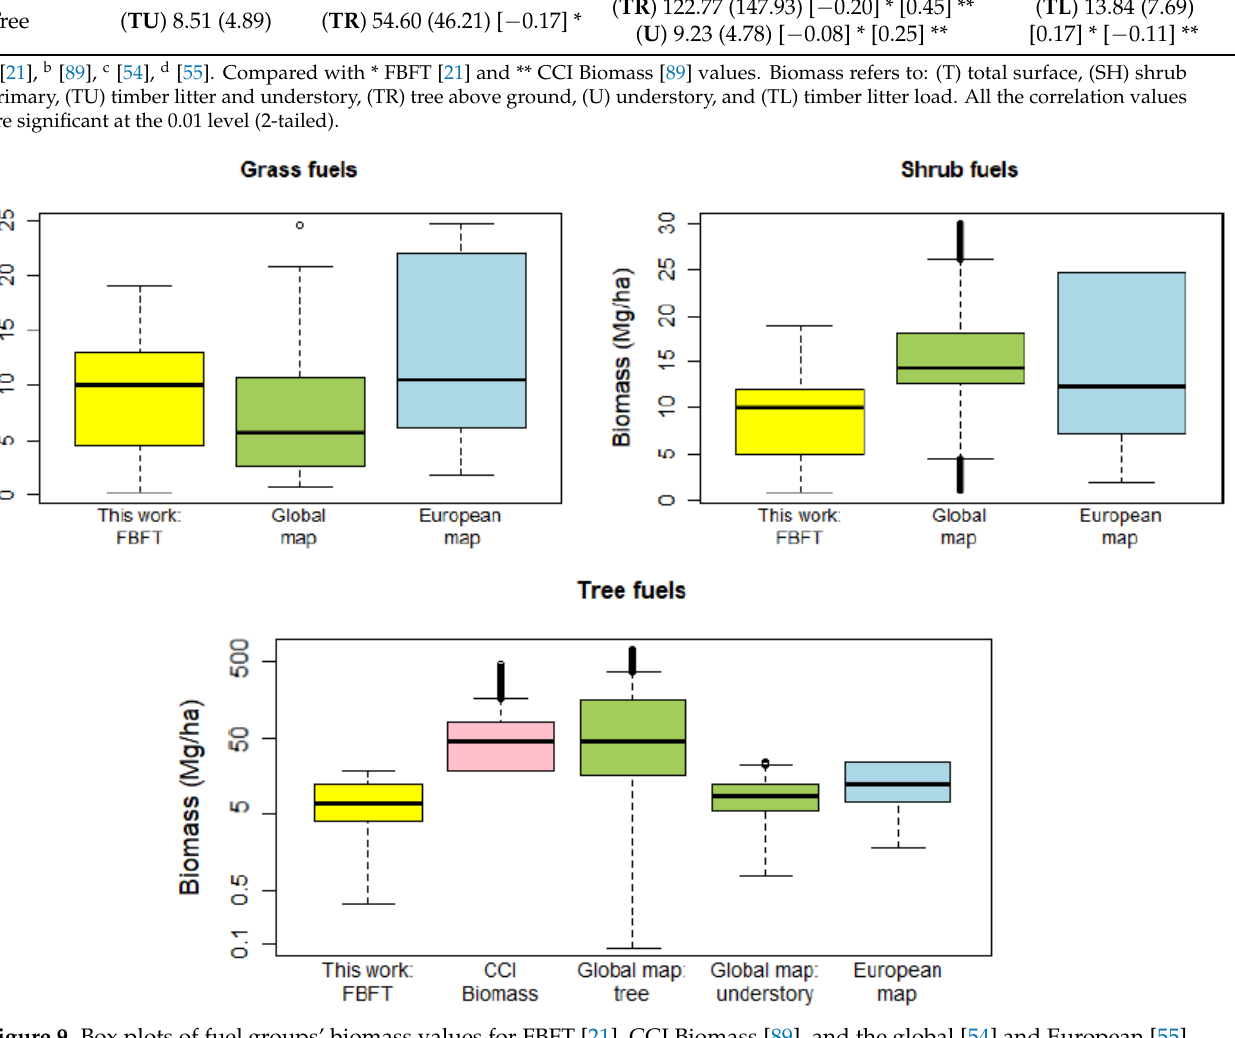
Figure 9. Box plots of fuel groups’ biomass values for FBFT [21], CCI Biomass [89], and the global [54] and European [55] fuel maps. Note that the bottom graph’s scale is logarithmic.